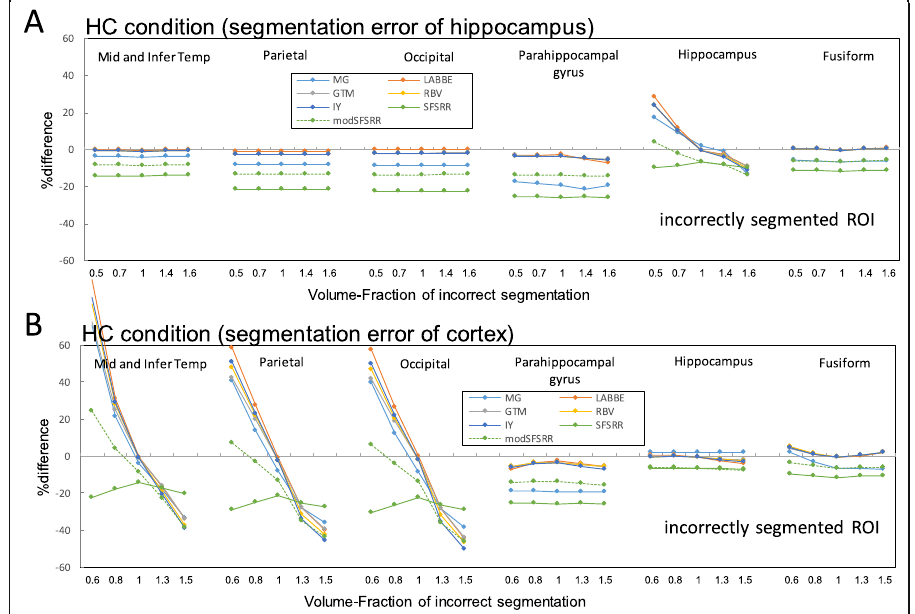
Fig. 8 %difference of PVC-SUVRs with segmentation error against true SUVRs. a Local (hippocampus) and b global segmentation errors. ROI template was from incorrectly segmented anatomical